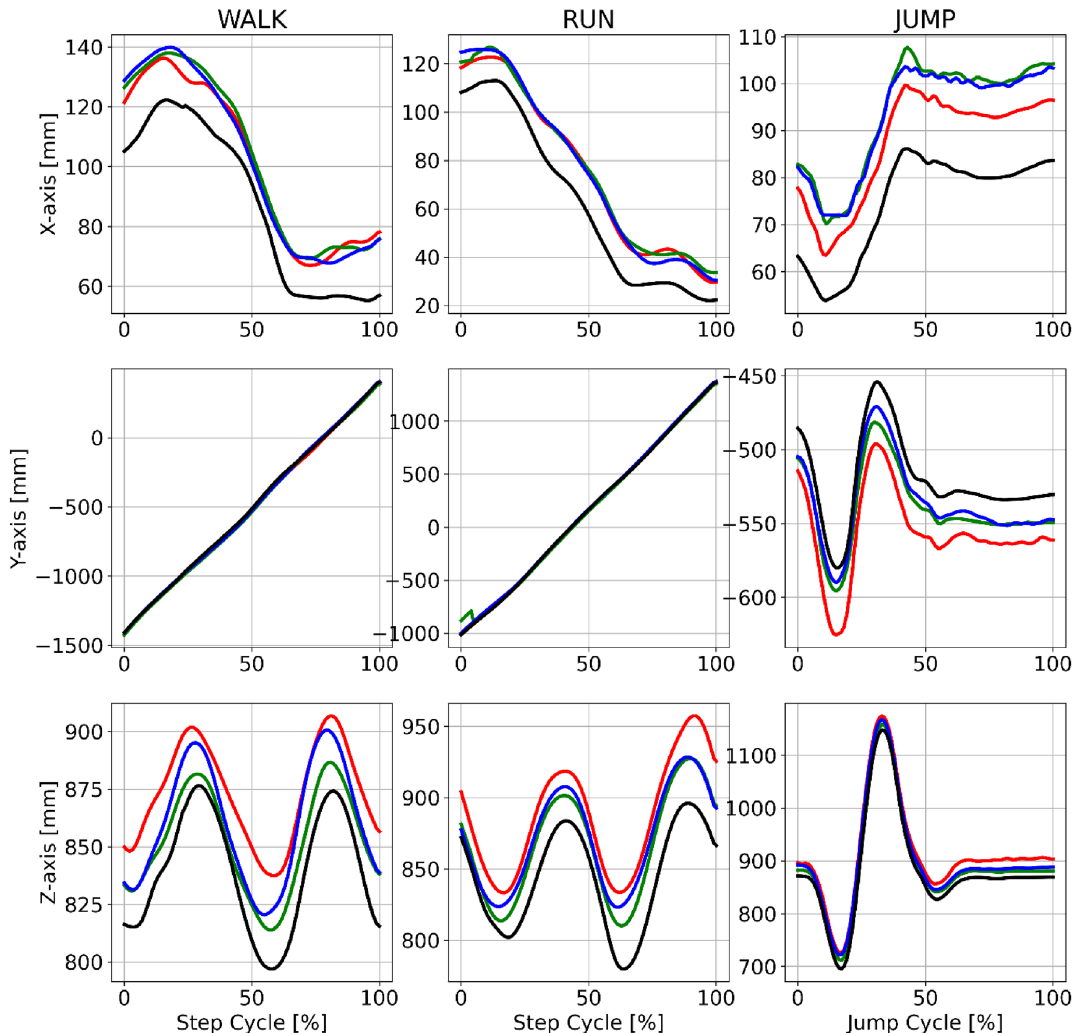
Figure 2. Example mean right hip joint centre trajectories for a single participant (P10) during walking (left), running (centre) and jumping (right) in the global coordinate system axes. Marker based trajectories (black), OpenPose (green), AlphaPose (blue) and DeepLabCut (red). X-axis = medial–lateral. Y-axis = anterior–posterior. Z-axis =